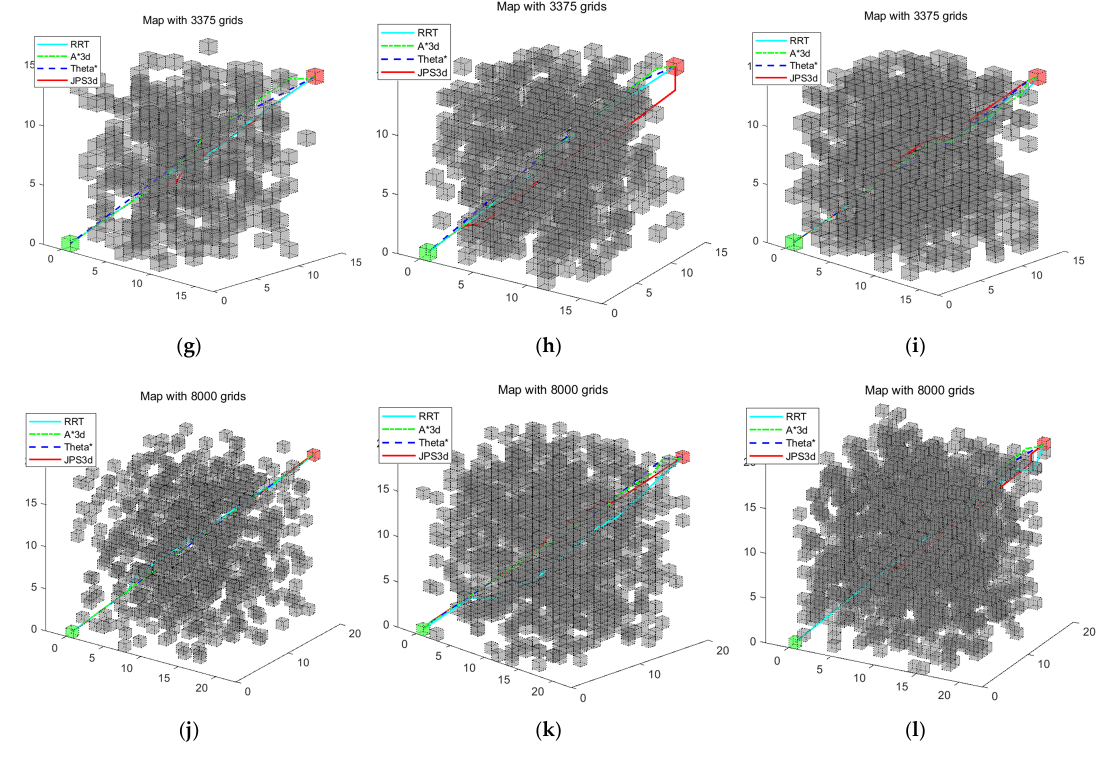
Figure 15. Experimental comparison of algorithms based on randomness maps. ( a ) Obstacles accounted for 20%. ( b ) Obstacles accounted for 30%. ( c ) Obstacles accounted for 40%. ( d ) Obstacles accounted for 20%. ( e ) Obstacles accounted for 30%. ( f ) Obstacles accounted for 40%. ( g ) Obstacles accounted for 20%. ( h ) Obstacles accounted for 30%. ( i ) Obstacles accounted for 40%. ( j ) Obstacles accounted for 20%. ( k ) Obstacles accounted for 30%. ( l ) Obstacles accounted for 40%.